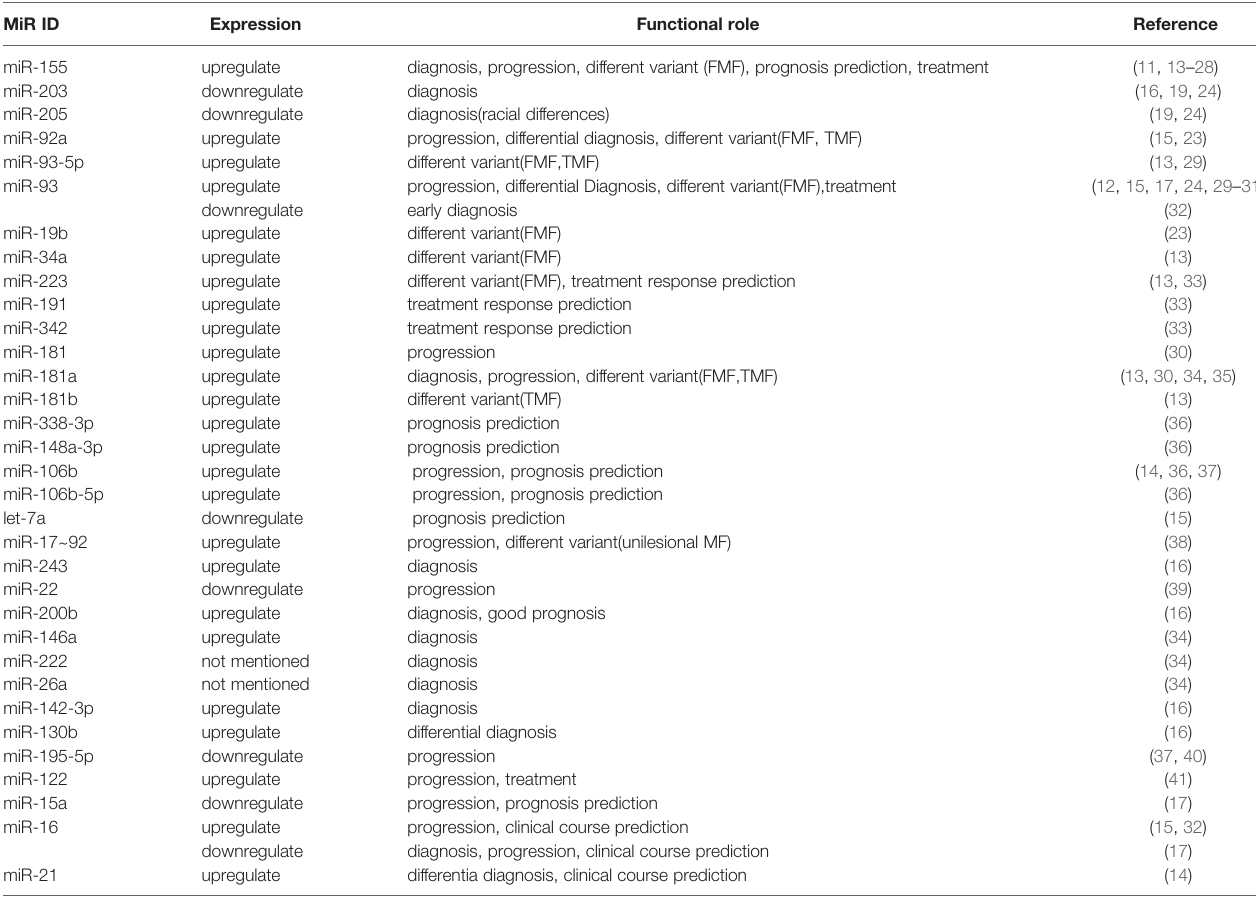
TABLE 1 | miR expression pro fi les of available studies in